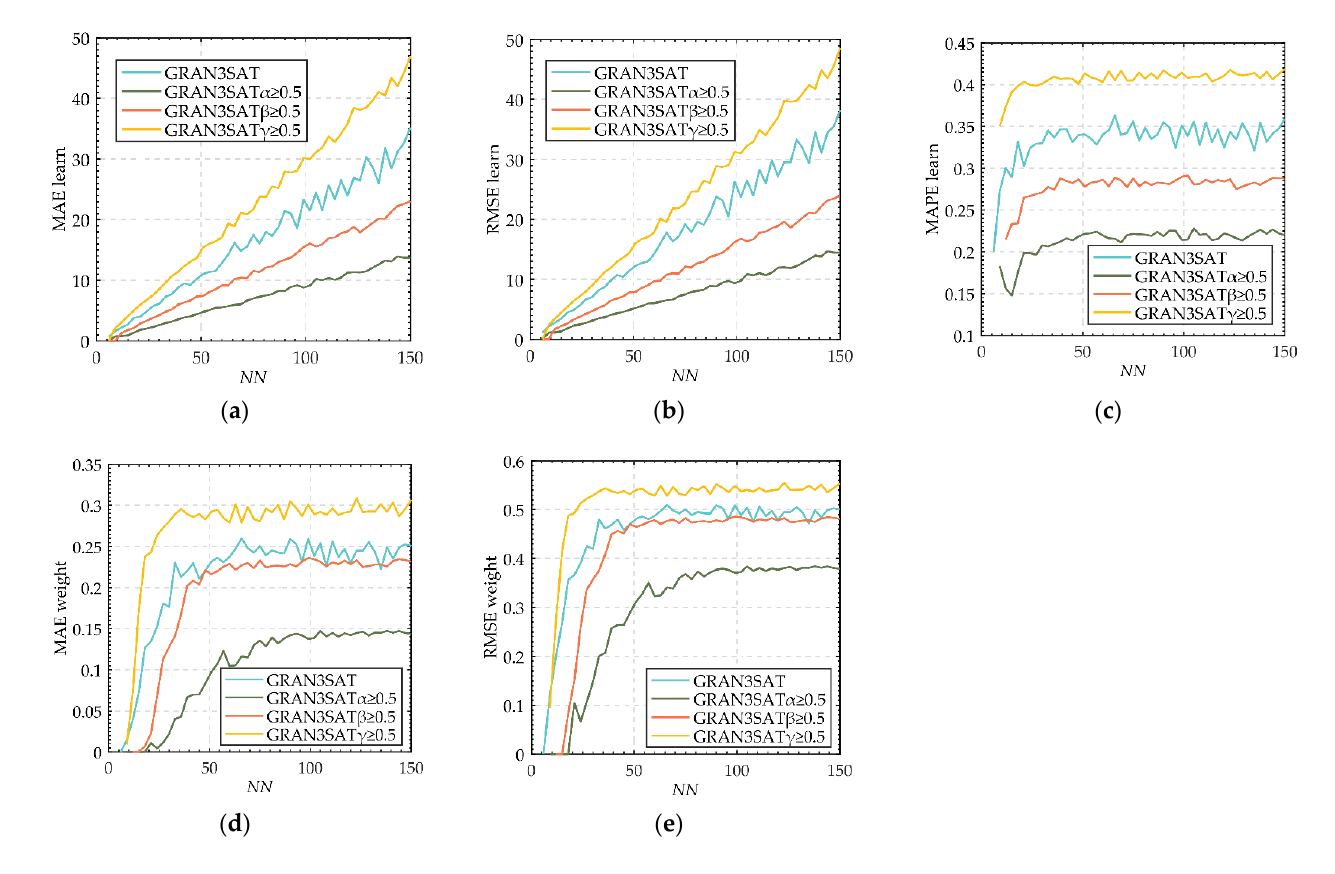
Figure 3. Error performance for ( a ) MAE learn , ( b ) RMSE learn , ( c ) MAPE learn , ( d ) MAE weight , and ( e ) RMSE weight . . Figure 3d,e demonstrate the MAE weight and RMSE weight for all GRAN3SAT